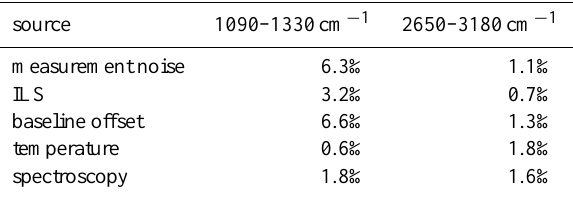
Table 6. Estimated random errors of column integrated δ D for re- trievals in different spectral